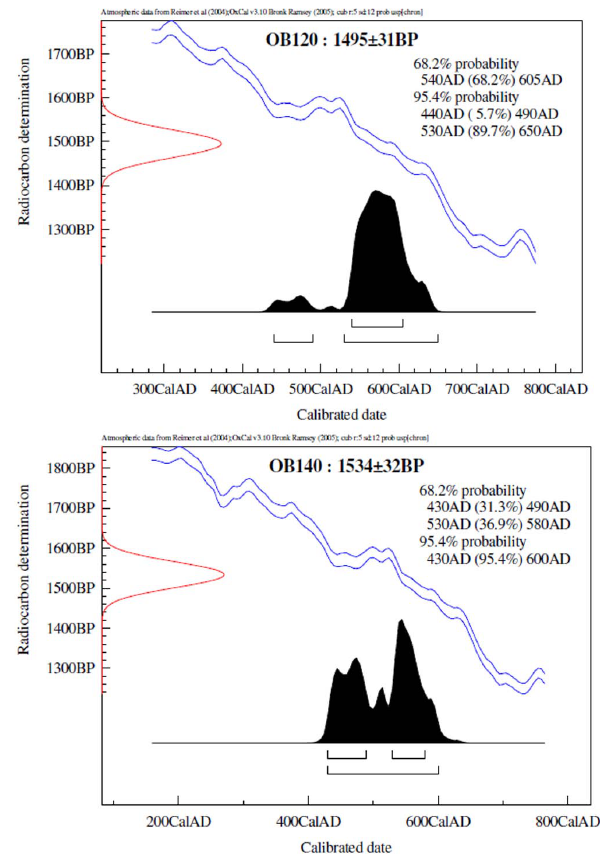
Fig. 7. Radiocarbon calibrated results from samples OB1.2 120cm and OB1.2 140cm. Please note that range of ages obtained